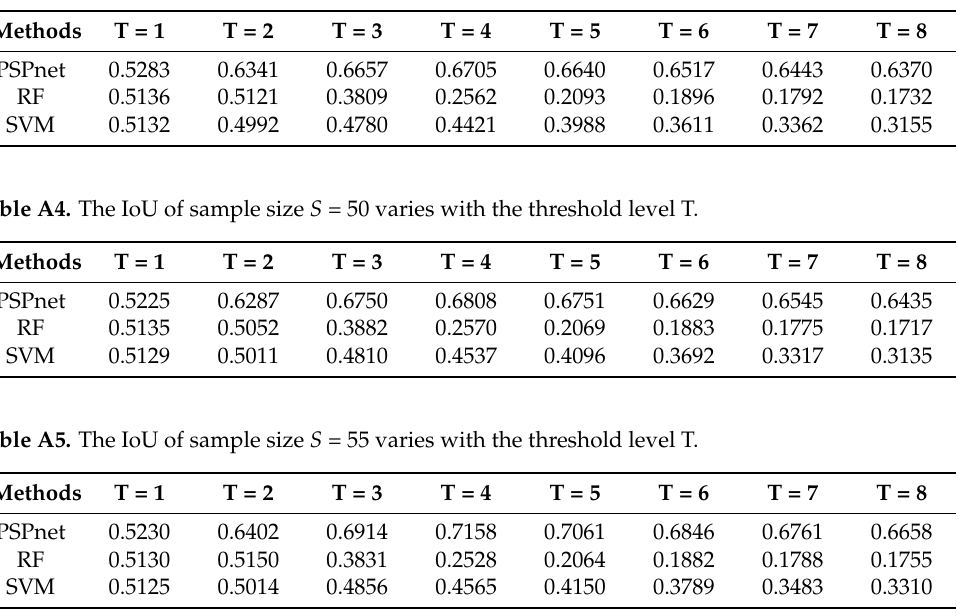
Table A3. The IoU of sample size S = 45 varies with the threshold level T.